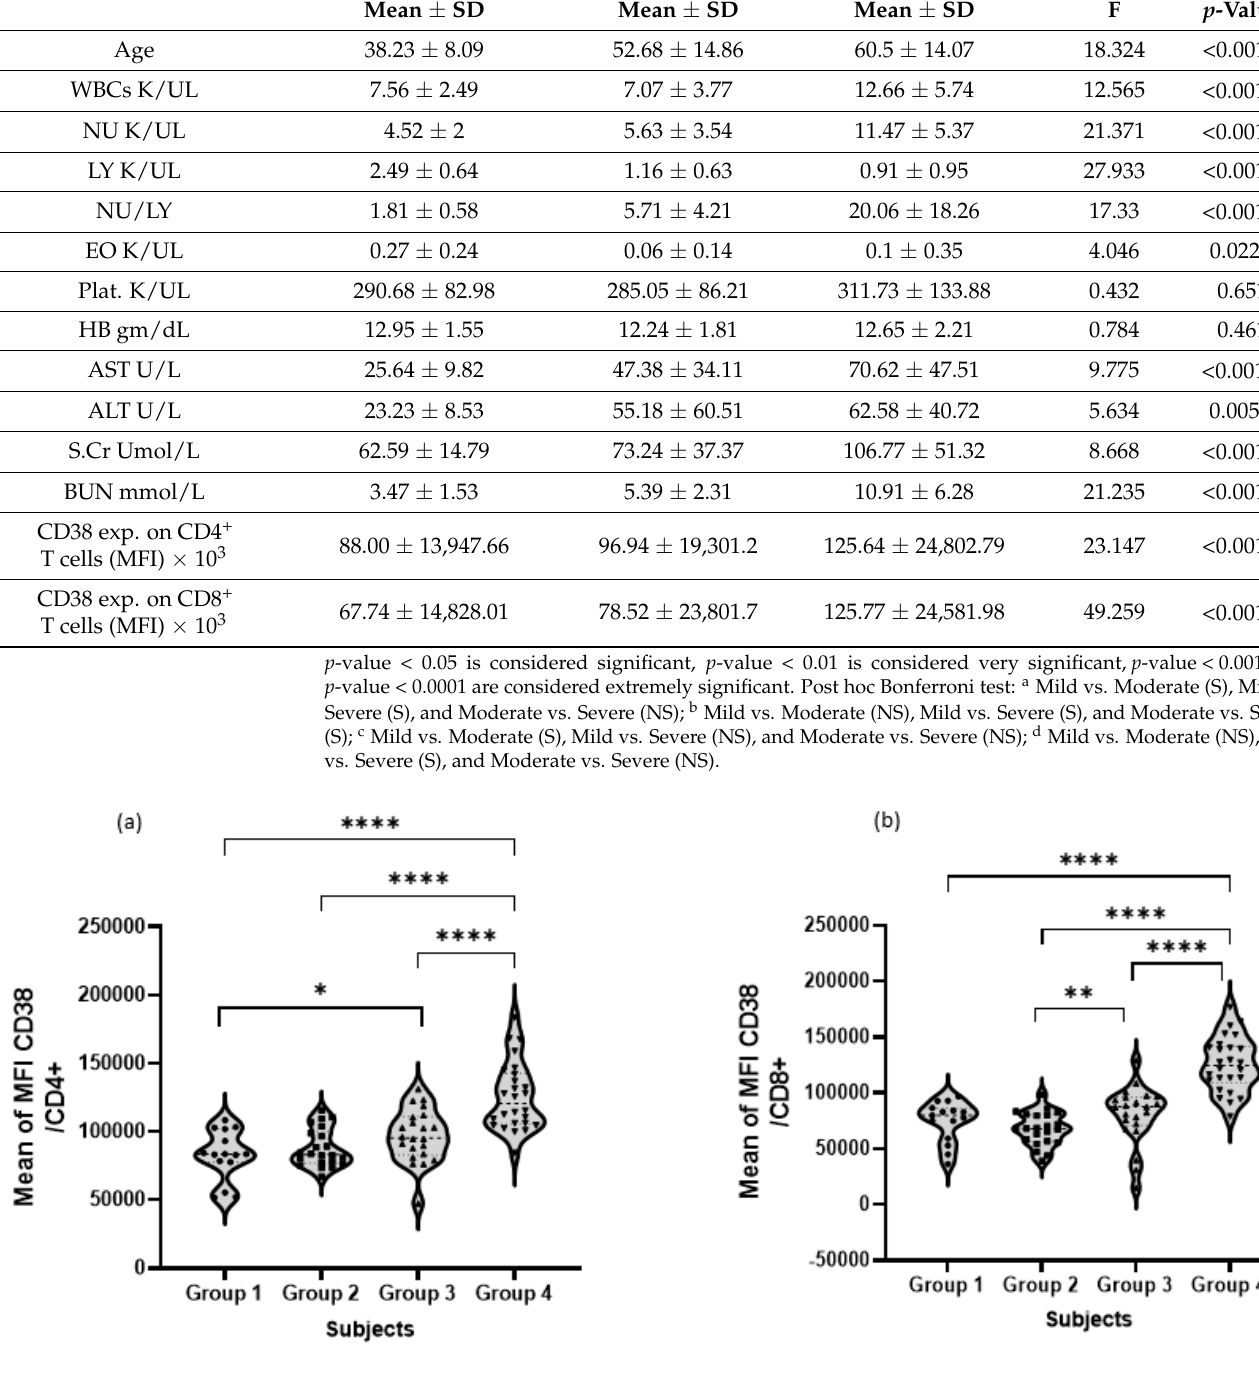
Figure 4. Comparison of CD38 expression (mean MFI) in ( a ) Th CD4 + T cell ( t -test) and ( b ) Tc CD8 + T cell (Mann–Whitney) subtypes between controls and different COVID-19 patients. Data represent a statistically significant increase in CD38 expression among the patients of the severe group in both T cell subtypes. * p -value < 0.05 is considered significant; ** p -value < 0.01, **** p -value <